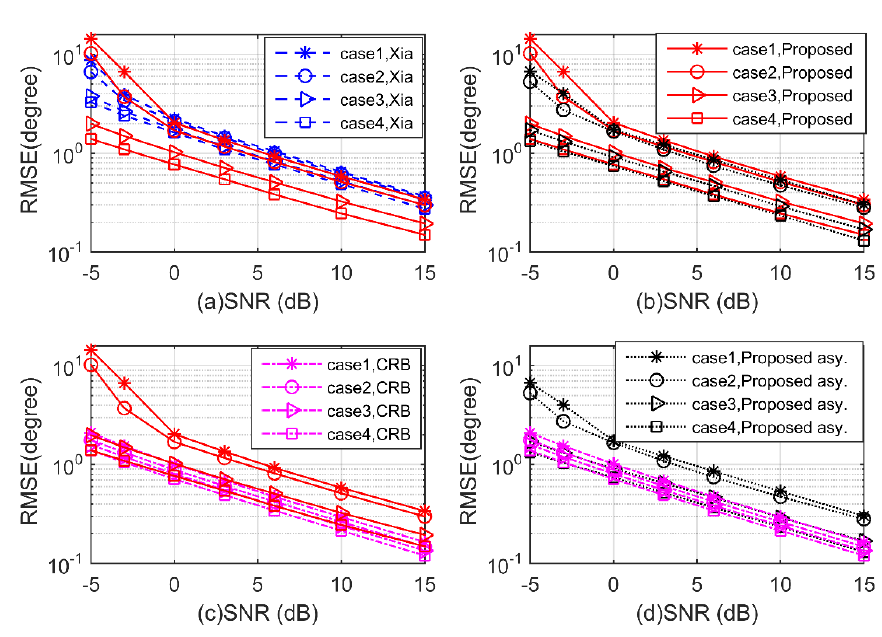
Figure 7. RMSE of 2D-DOA for mixed signals versus SNR ( a – d ).